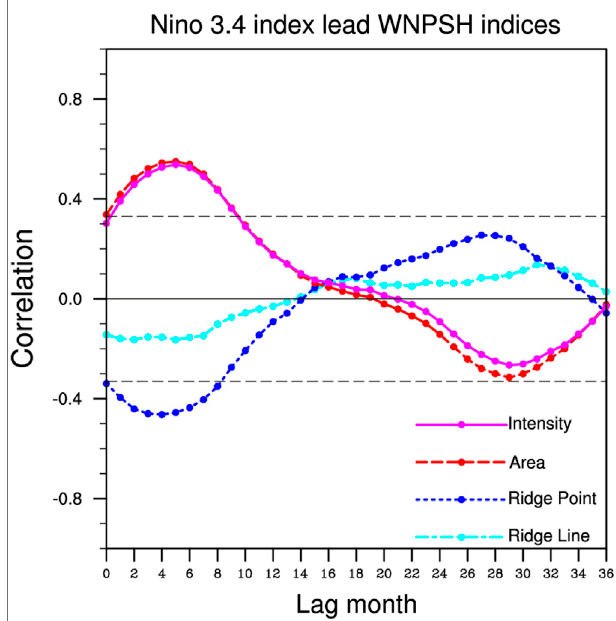
FIGURE 4 | Lagged correlations between Niño 3.4 index and WNPSH indices. Only annual cycle is removed from WNPSH indices before calculating the lagged correlations. The dashed lines are the signi fi cant correlation values at the 95% con fi dence level, where the degree of freedom is estimated by each